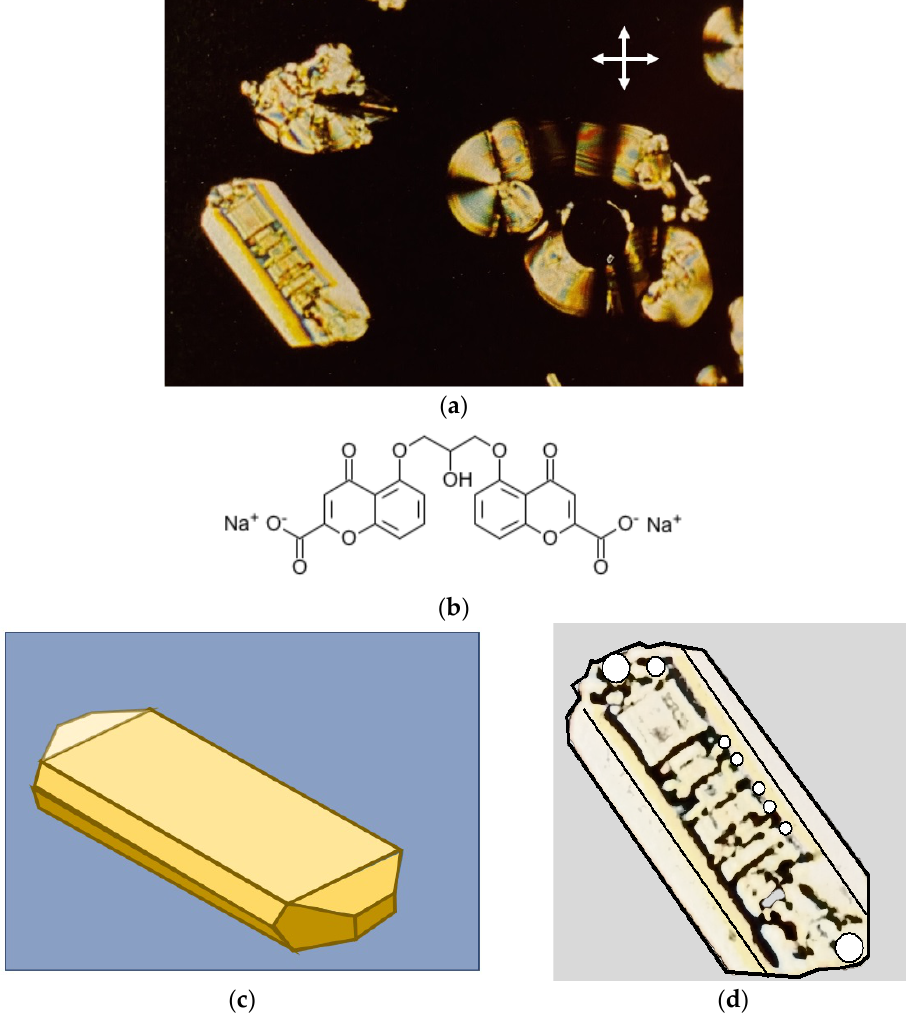
Figure 1. ( a ) A reproduction, with the permission of Microscope Publications, of the frontispiece in Hartshorne’s 1974 textbook, The Microscopy of Liquid Crystals , [1] showing regions of the mesophase of Intal forming in the isotropic liquid [1]. ( b ) The molecular structure of the Intal. ( c ) The habit of a single crystal of Intal. ( d ) Enhanced image of the decorated “batonnet” in ( a ), with some circular features outlined.